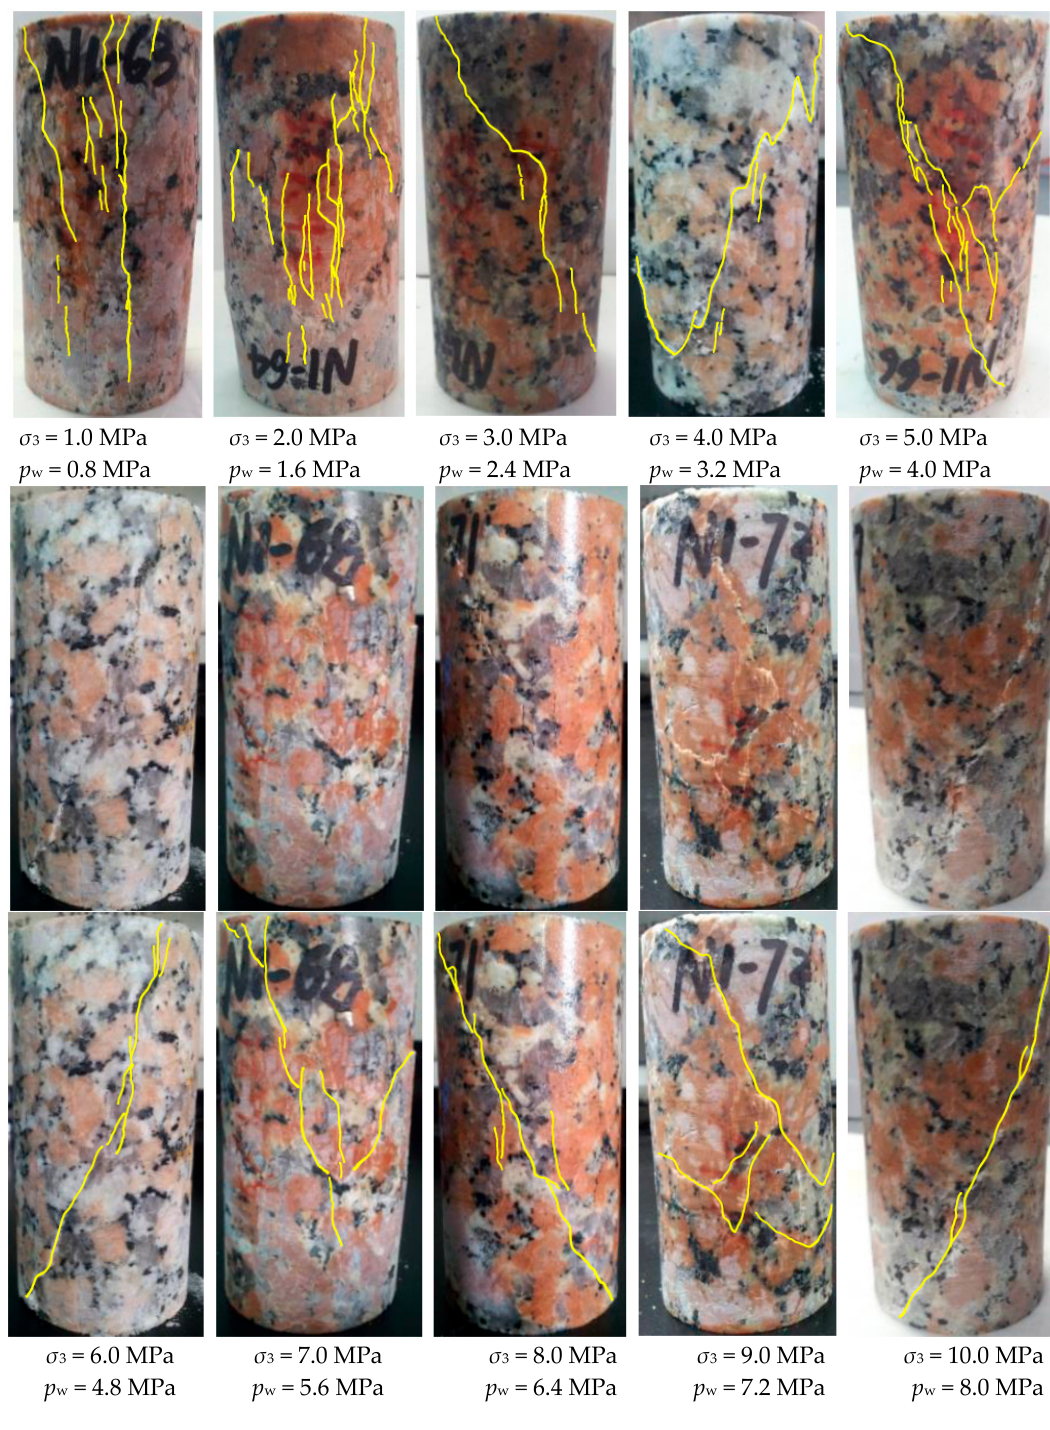
Figure 7. Fracturing patterns of NRG01 granite samples under various confinements and water pressure. The yellow lines in the lower pictures show the fractures compared with the original pictures of the samples.